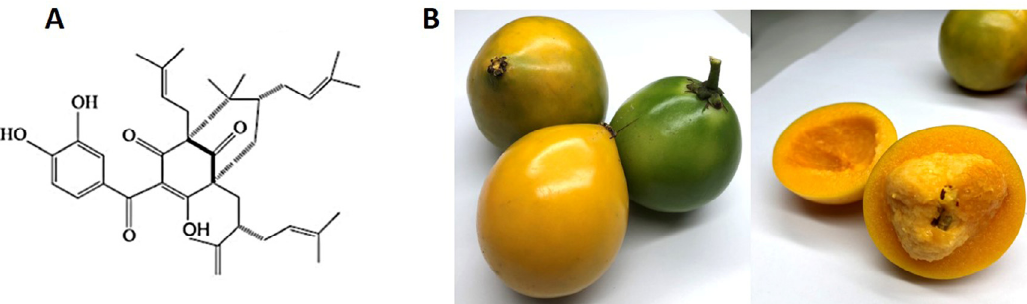
Figure 1. Chemical structure of garcinol ( A ) and Garcinia dulcis fruit ( B